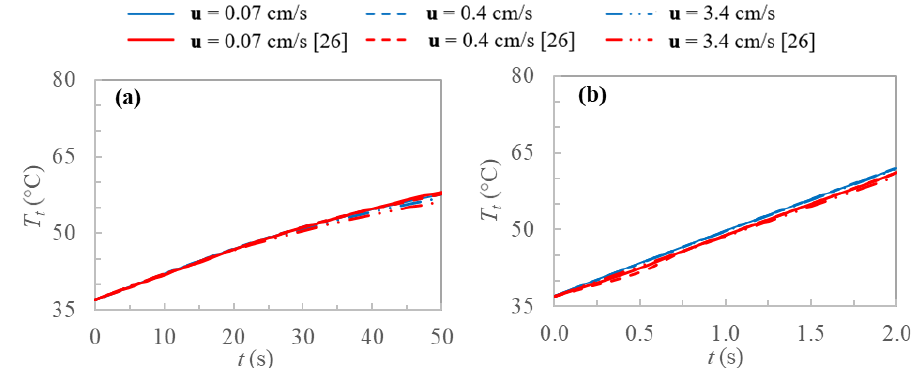
Figure 4. Tissue temperatures profiles evaluated at the center of the sphere for current work and [26]: ( a ) ε = 0.005, Q ext = 2 × 10 6 W m −3 and ( b ) ε = 0.05, Q ext = 50 × 10 6 W m −3 .